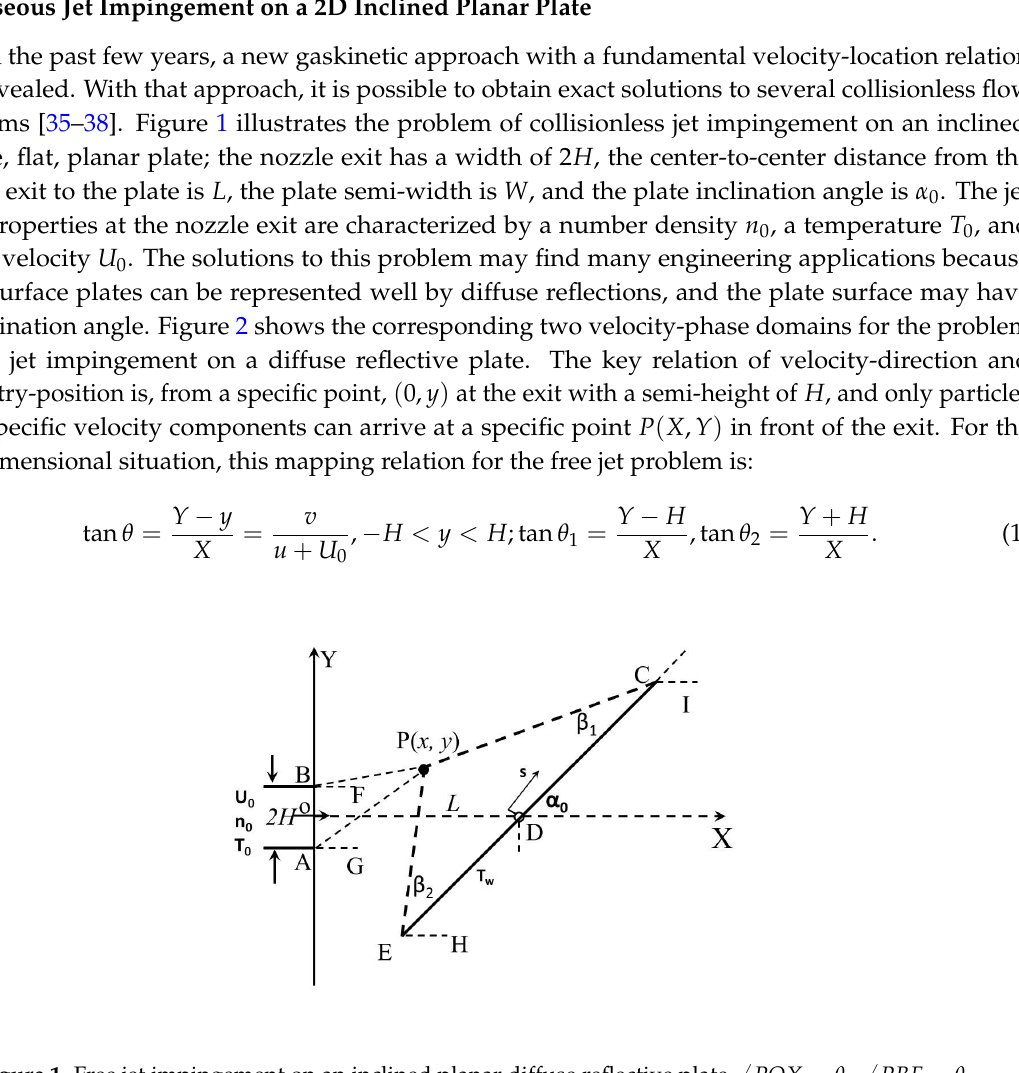
Figure 1. Free jet impingement on an inclined planar diffuse reflective plate, (cid:54) POX = θ 0 , (cid:54) PBF = θ 1 , (cid:54) PAG = θ (cid:54) PEH = θ (cid:54) ICP = θ = α + β = α + π − β 2 , 3 0 2 , and 0 4 1